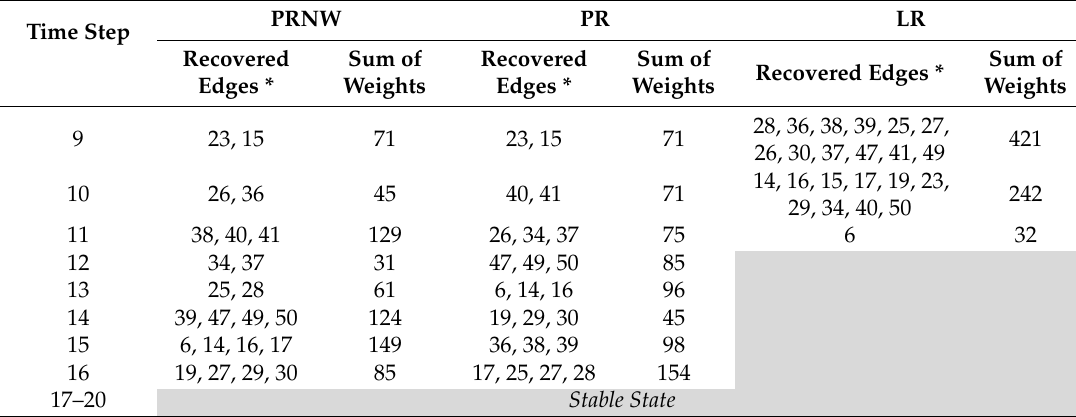
Table 6. Iteration details of recovery strategies.